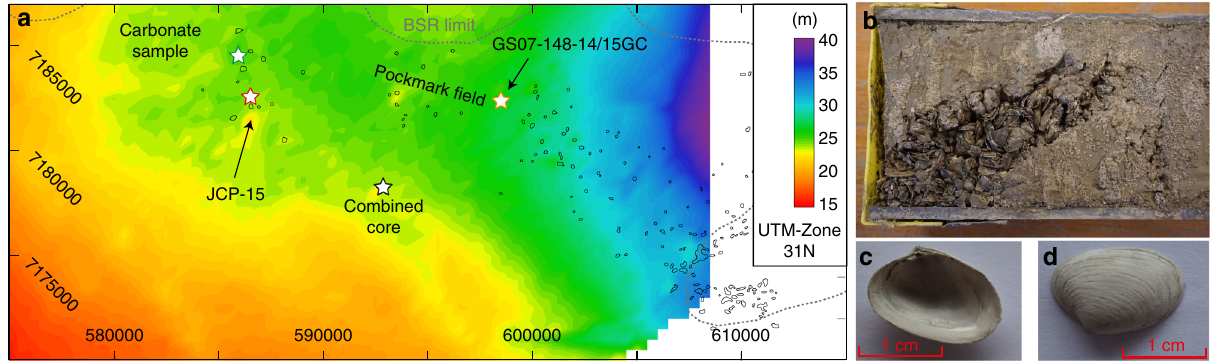
Fig. 5 Simulated distribution of gas hydrate dissociation. a Map showing the distribution of gas hydrate dissociation at 17.8 ka with pockmark location 7 , extent of gas hydrates indicated by a BSR (Bottom-simulating re fl ector; dashed black lines 8 ), and coring and sample locations. b Photograph showing the beginning of section 2 of gravity core GS07-148-14GC with a pronounced accumulation of intact and fragmented shells of Isorropodon nyeggaensis. c , d Photographs of Isorropodon nyeggaensis shell from